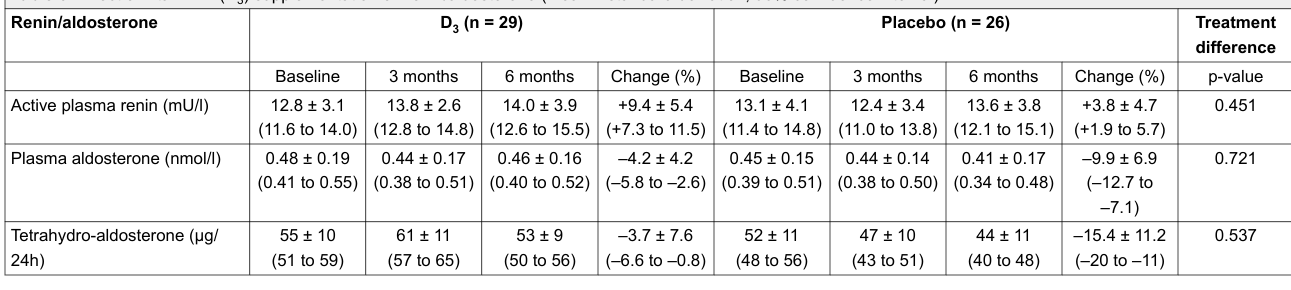
Table 6: Effect of vitamin D (D 3 ) supplementation on renin/aldosterone (mean ± standard deviation, 95% confidence interval). Renin/aldosterone